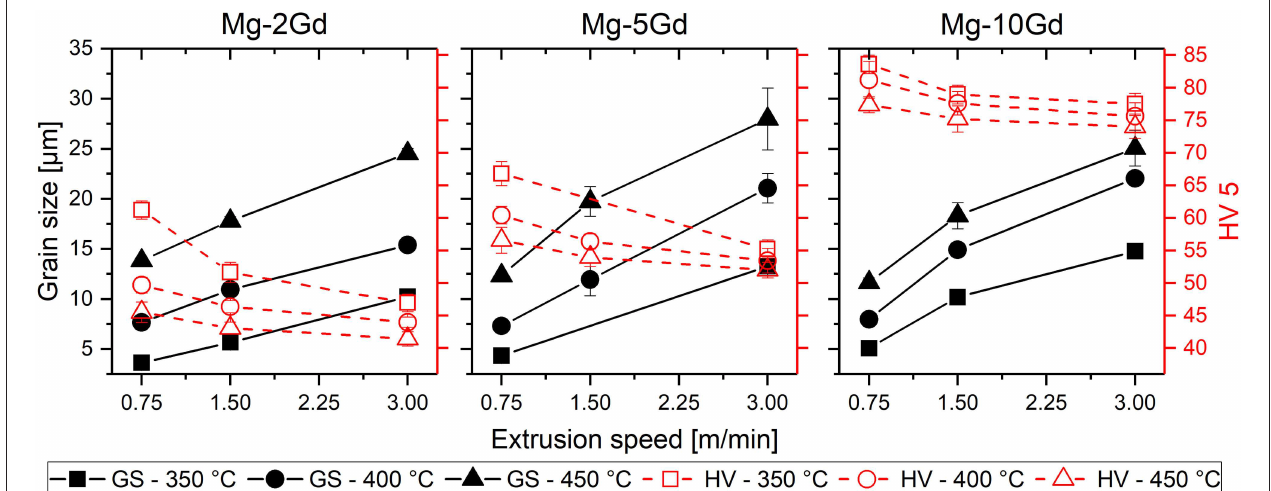
FIGURE 3 | Grain sizes (solid) and hardness (empty) for all alloys with respect to individual extrusion conditions. With increasing extrusion parameters, grain sizes trend higher, hardness values trend lower. Alloy composition is not affecting grain sizes but hardness values are significantly increased with higher Gd additions. Error bars are standard deviations.